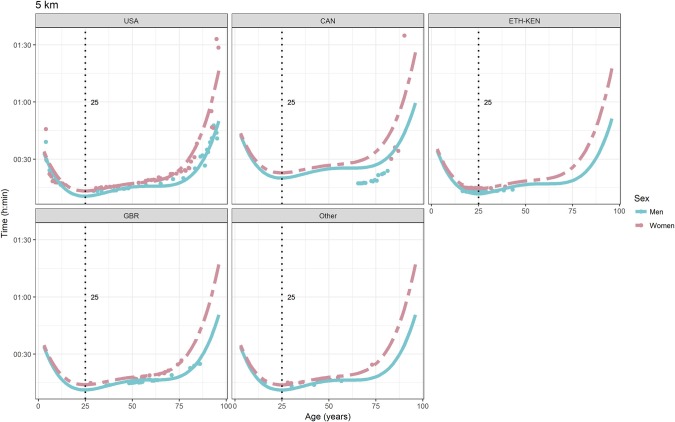
World record in 5 km by sex, age (in years), and country. Points were observations. Curves represented quartic degree polynomial regression. Vertical line with the numeric label was the age at peak performance.